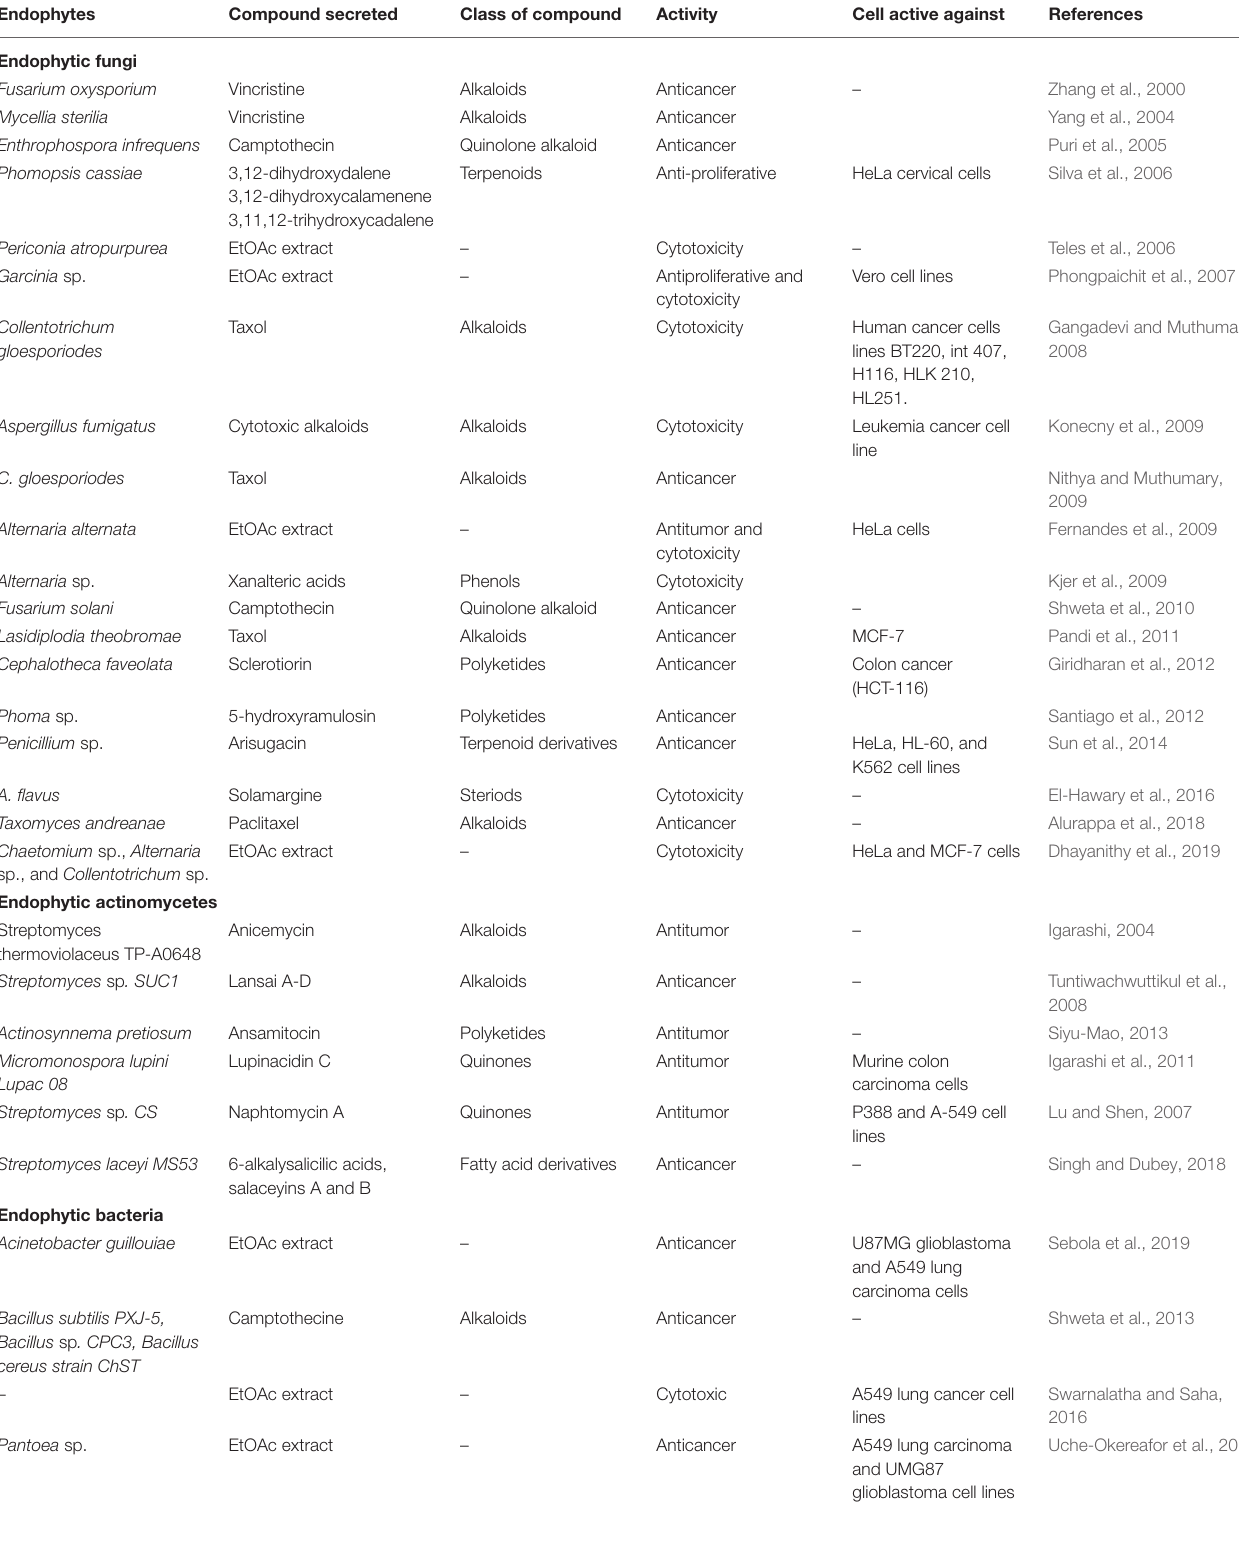
TABLE 2 | Summary of studies on the anticancer prospects of